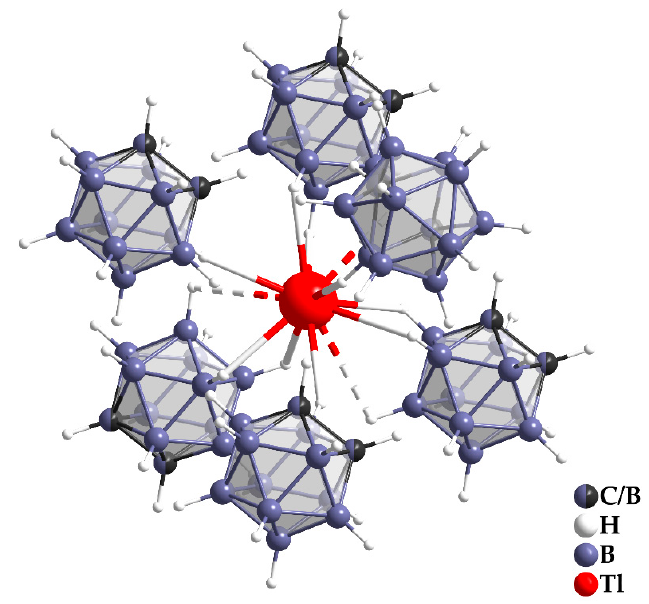
Figure 3. Coordination sphere of the singular Tl + cation in the crystal structure of Tl[CB 11 H 12 ] by twelve hydrogen atoms (C.N. = 9 + 3) of six monocarbaborate anions [CB 11 H 12 ] − .